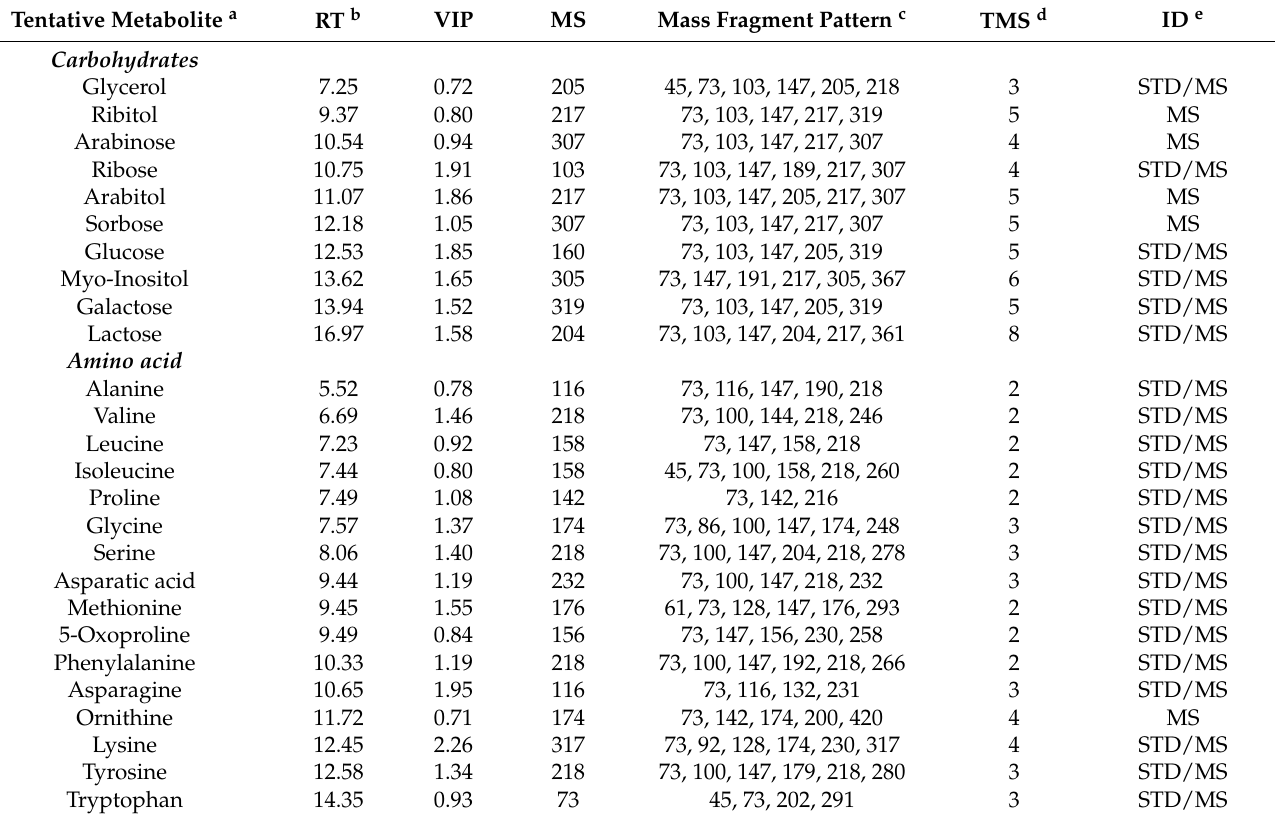
Table 1. The candidate metabolites altered by heat stress as identified by gas chromatography–time- of-flight mass spectrometry (GC-TOF-MS)